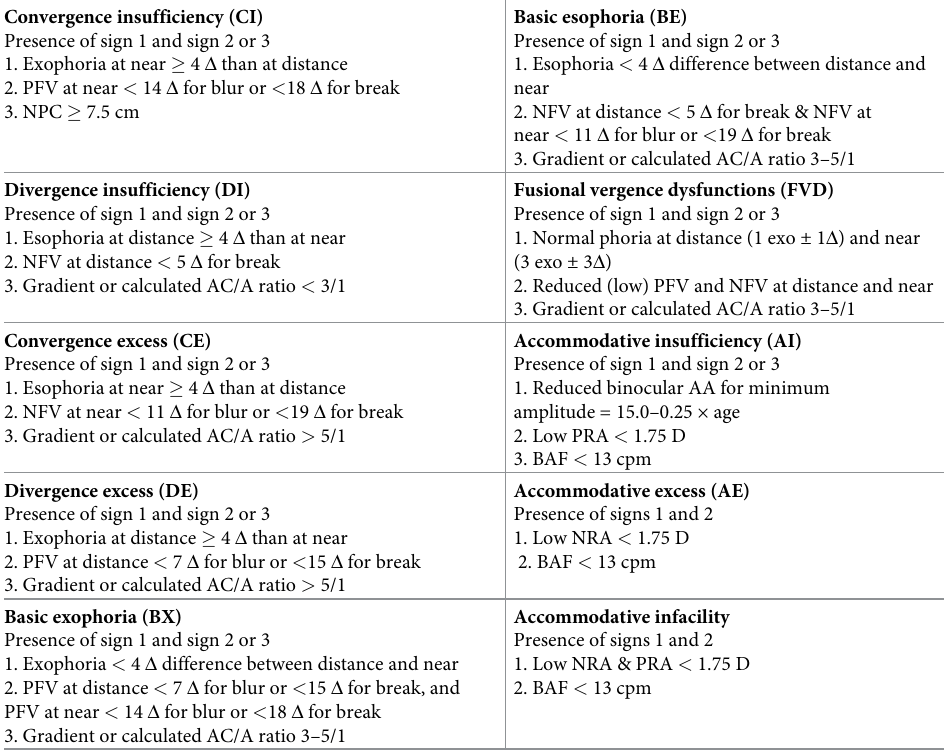
Table 1. Diagnostic criteria for non-strabismic binocular vision